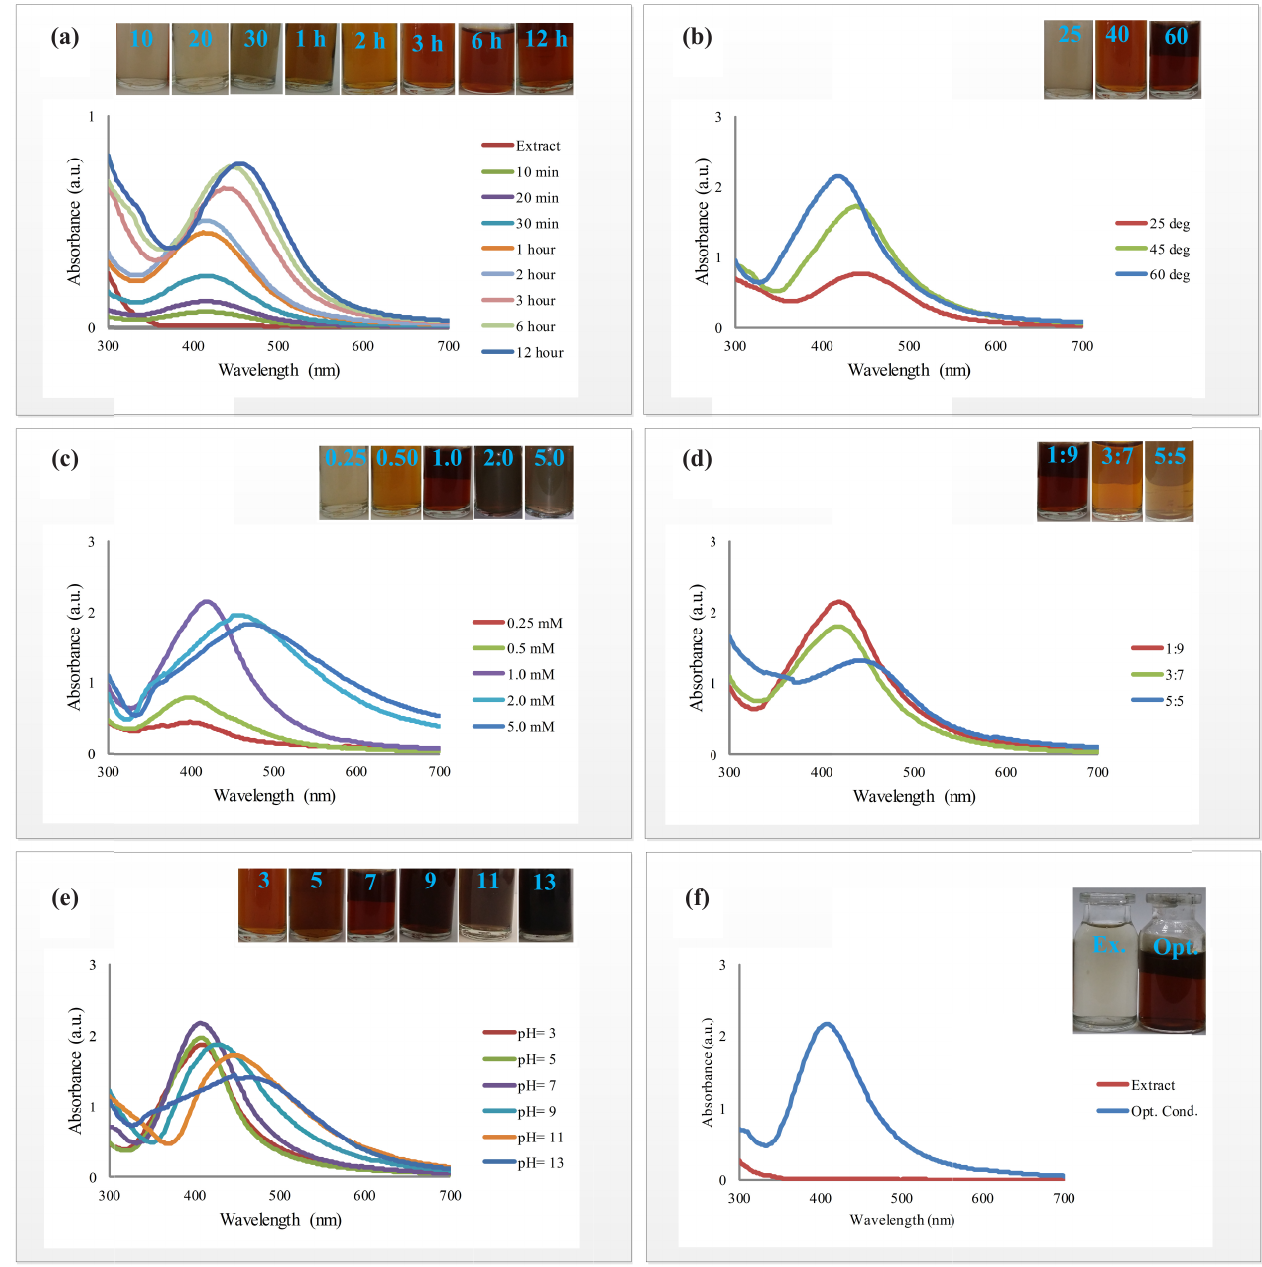
Fig. 1. Visual observation and UV-Vis absorption spectra of the silver nanoparticles at (a) different reaction time, (b) different reaction temperature, (c) different silver nitrate concentration, (d) different concentration ratio of the extract and silver nitrate, (e) different pH, and (f) optimum condition including: reaction time, 6 hours; silver nitrate concentration, 1 mM; temperature, 60°C, extract pH, 7; and concentration ratio of the extract and silver nitrate, 1:9